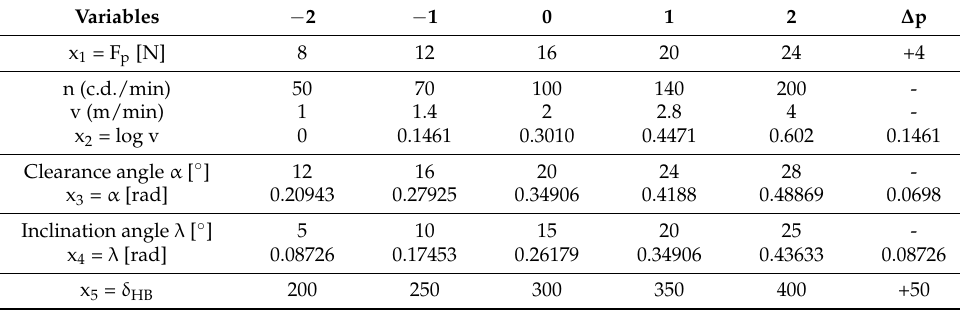
Table 1. The intervals of the independent